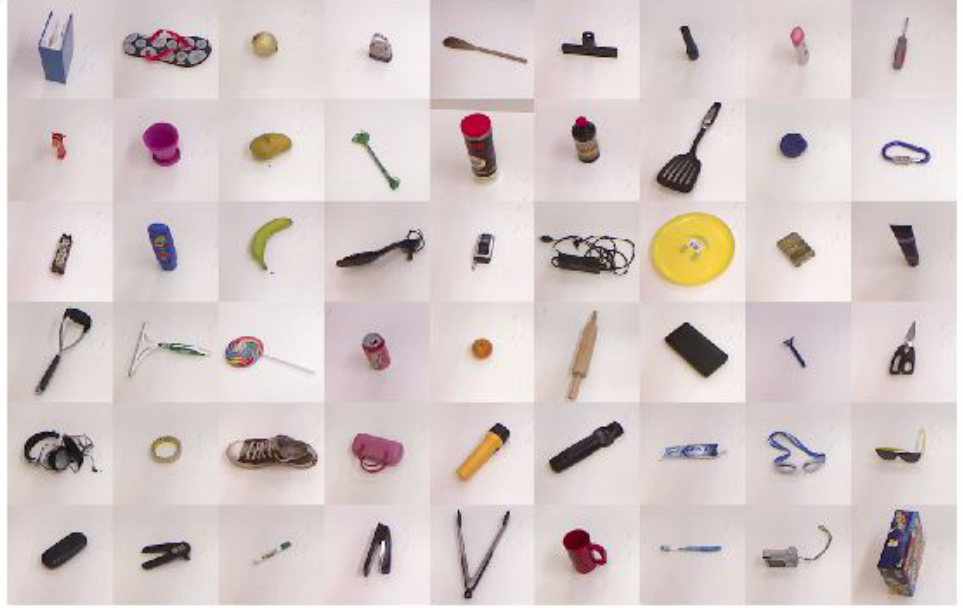
Figure 4. Sample of Cornell Grasp dataset